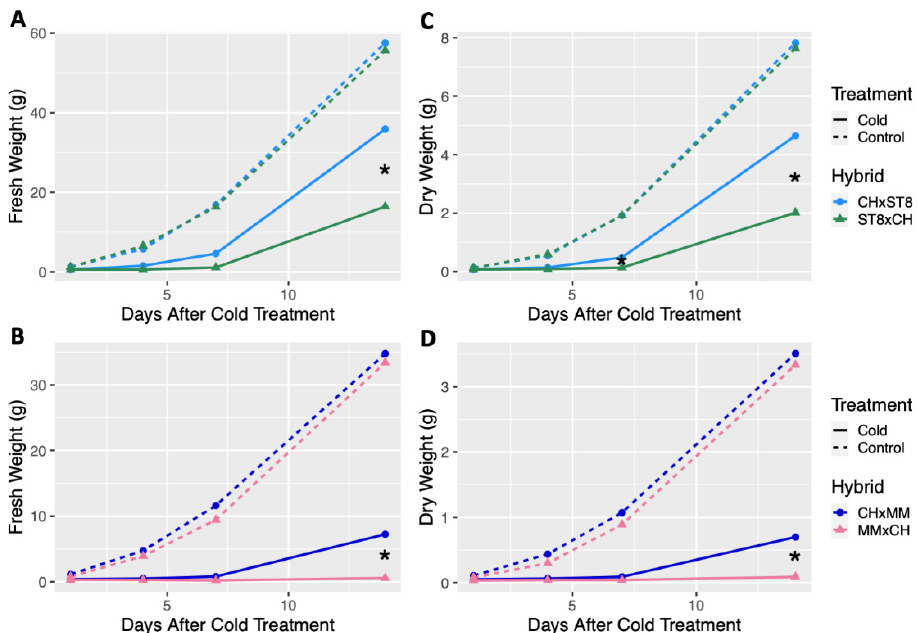
Figure 2. Least-square means of fresh and dry weight of reciprocal hybrids plotted over timepoints 1, 4, 7, and 14 days after cold treatment. Cold tolerant ‘Chipper’ (CH) was reciprocally crossed with ( A , C ) ‘Straight 8’ (ST8) and ( B , D ) ‘Marketmore 76’ (MM). Plants were grown in a greenhouse at 28 °C for 10 days then plants were either treated at 4 °C for 5.5 h at a light intensity of 270 µmol·s − 1 ·m − 2 (Cold) or remained in the greenhouse (Control). Plants were harvested by cutting just above the cotyledon. Hybrids were compared within each timepoint and treatment. * indicates significant difference between reciprocal hybrids based on Tukey’s HSD ( p < 0.05).